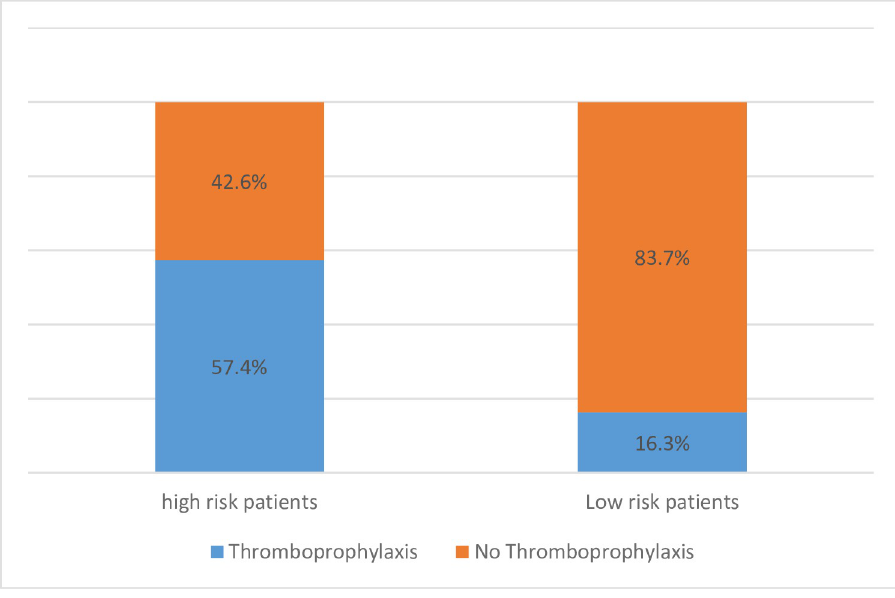
Fig 2. Thromboprophylaxis in patients at high risk of thromboembolic complications according to the Belgian guidelines.